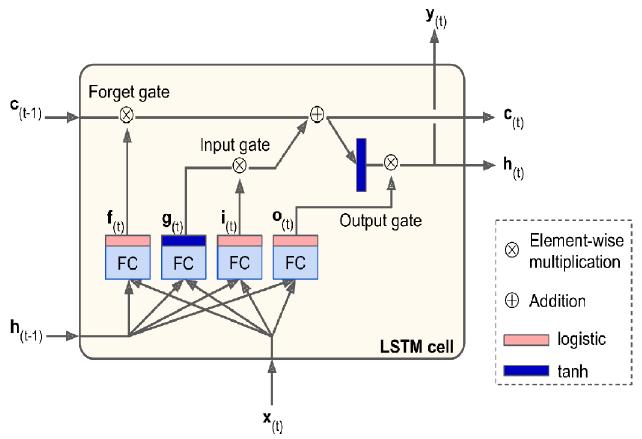
Figure 2. LSTM Gates